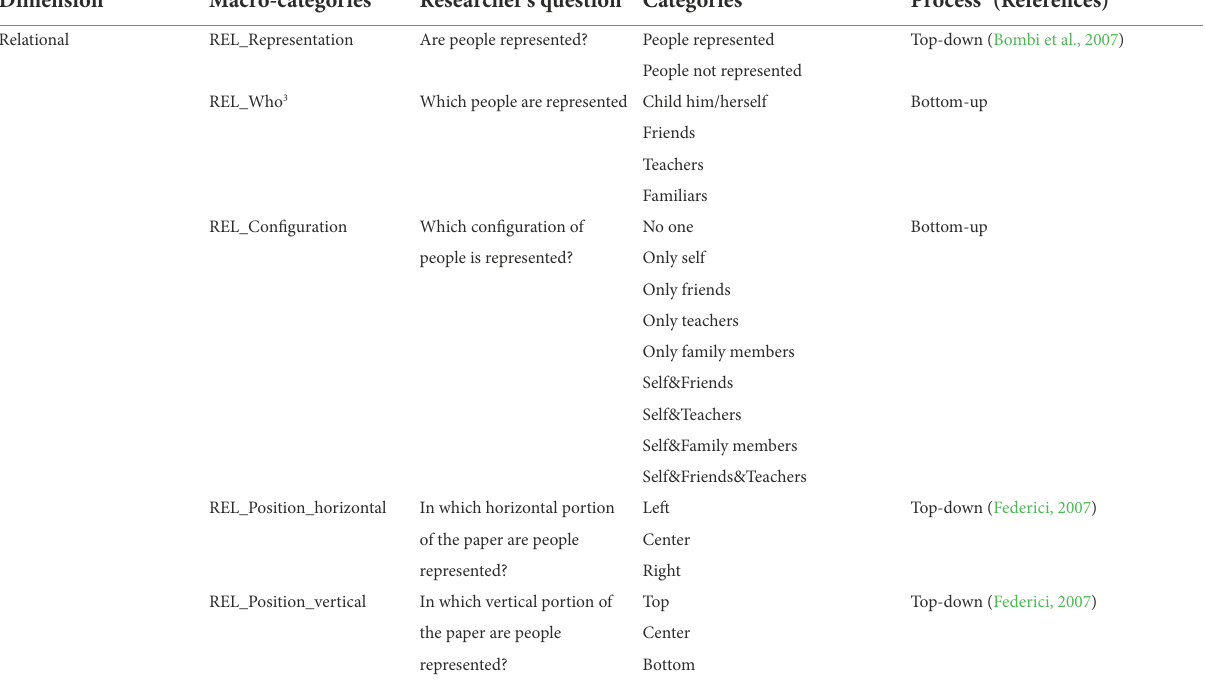
TABLE 3 Relational dimension: macro-categories and categories included in the DRAW.IN.G. grid.